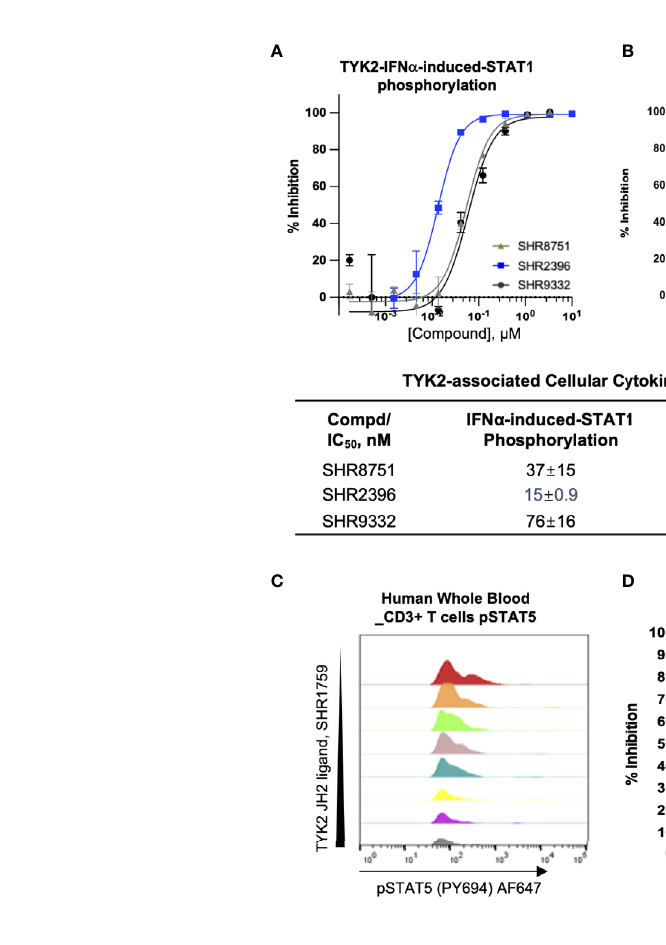
( Figures 5A – C ), as well as 1.8 nM and 220 nM against the JH2 domain of JAK1 and JAK2 ( Figures 5J, H ). The bindings are signi fi cantly weaker as compared to its af fi nity to the TYK2 JH2 (Kd = 0.04 nM, Figure 2 ). Other small molecule TYK2 pseudokinase binders demonstrated similar patterns (SHR8751, 2396, and Deucravacitinib; Figure 5 ). In contrast, the tested JAK/ TYK2 kinase inhibitors (TYK2 kinase inhibitor, Ropsacitinib;